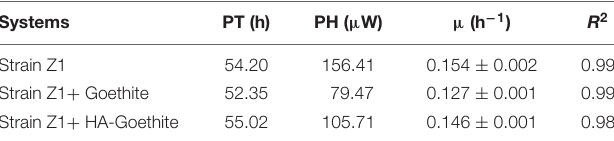
TABLE 2 | Thermokinetic parameters of Pseudomonas sp. Z1 utilizing MP as a sole carbon source in mineral systems.